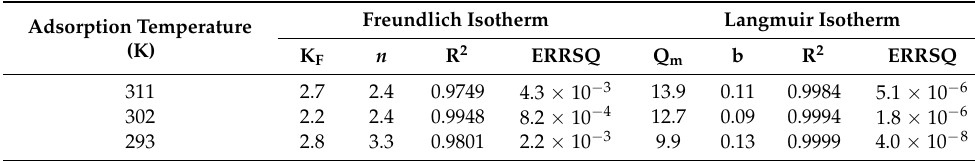
Table 5. Freundlich and Langmuir parameters, ERRSQ, and regression coefficients at different temperatures for the adsorption of TPC by Ox-AC/Cu/Cu 2 O/CuO. Freundlich Isotherm Langmuir Isotherm Adsorption Temperature (K)